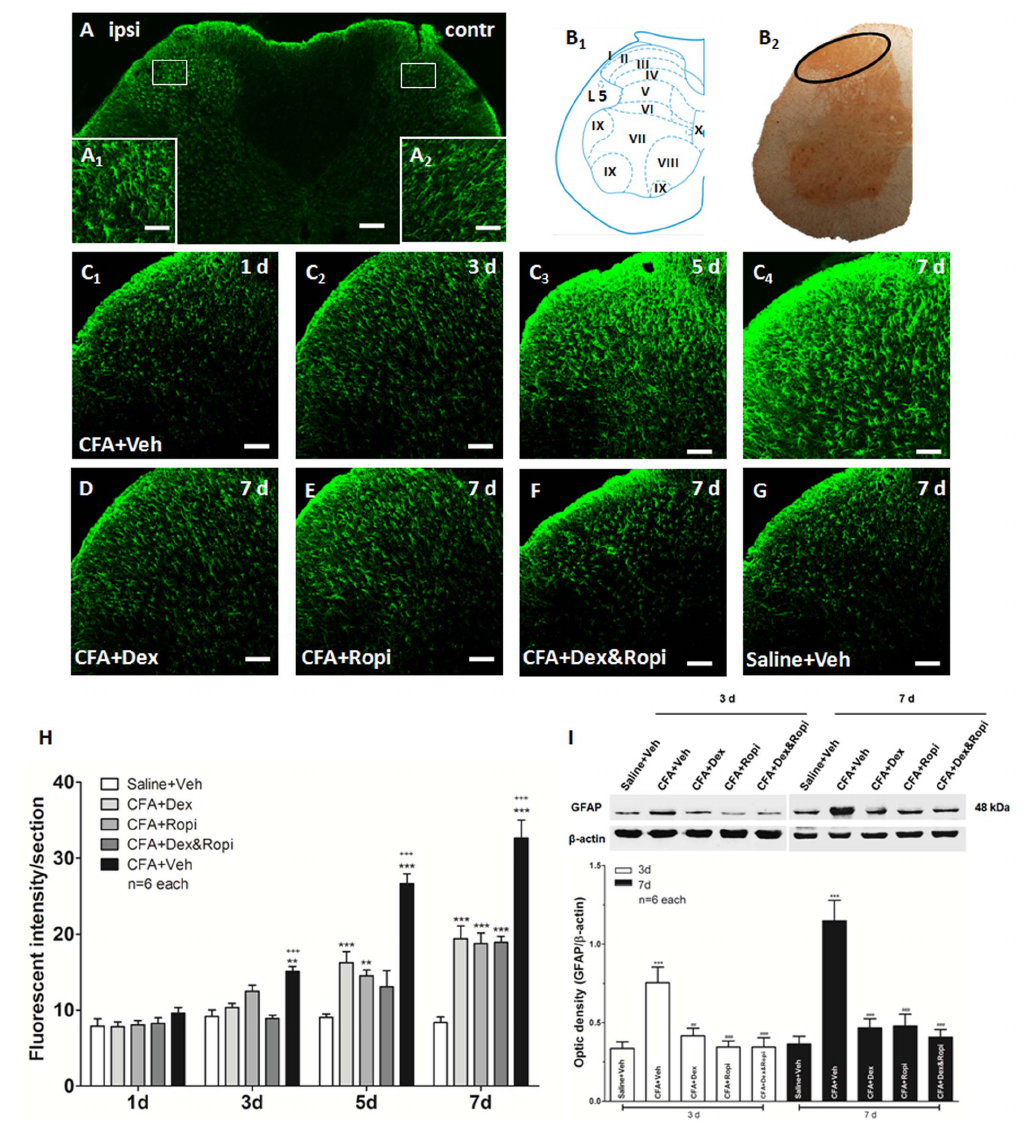
Figure 6. Effect of i.t. Dex, Ropi, or their combination on CFA-induced astrocytic activation. s.c. CFA injection induced appreciable astrocytic activation and GFAP up-regulation in the ipsilateral SDH ( A ). The activated astrocytes presented hypertrophied cell bodies and